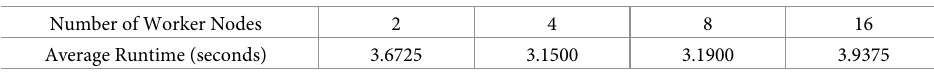
Table 3. Average execution time for querying rs671 with the binID on the partitioned Parquet files of one half of the 1000 Genomes dataset using Apache Presto, with different numbers of worker nodes. Each configuration addi- tionally includes one master